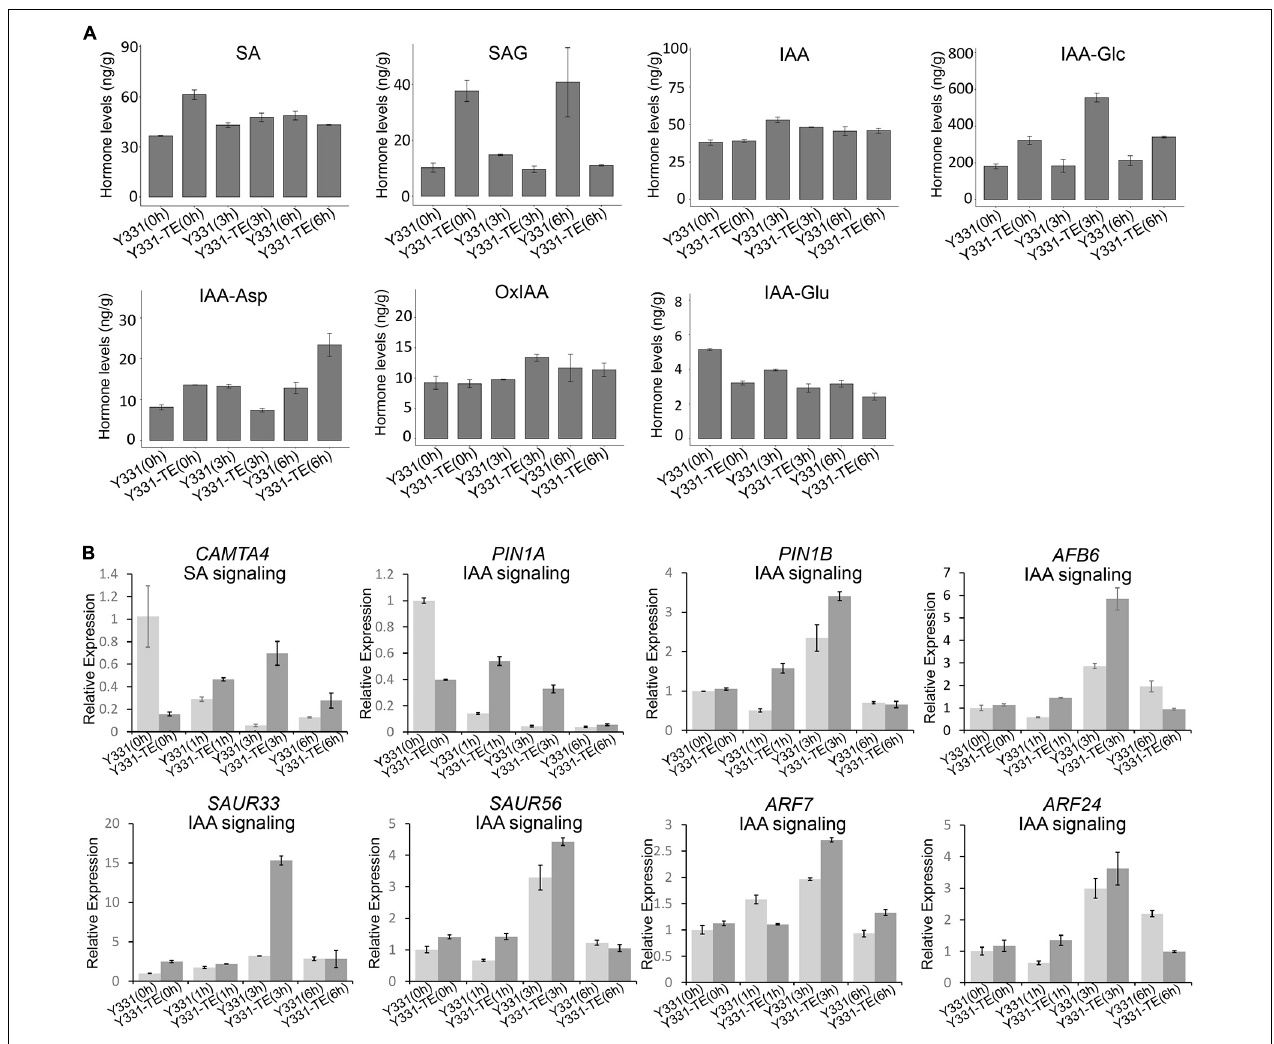
FIGURE 5 | Hormone level changes in Y331- (cid:49) TE and Y331 during infection of Fusarium graminearum. (A) Determination of endogenous maize hormone contents by LC-MS/MS during F. graminearum infection on Y331- (cid:49) TE or Y331 at different time points. SA, salicylic acid; SAG, salicylic acid 2-O- β -glucoside; IAA, indole-3-acetic acid; IAA-Asp, indole-3-acetyl- L -aspartic acid; IAA-Glc, 1-O-indol-3-ylacetylglucose; OxIAA, 2-oxindole-3-acetic acid; IAA-Glu, indole-3-acetyl glutamic acid. (B) Relative expression of hormone signaling pathway-related genes in F. graminearum -infected maize seedling root at different time points. The β -actin gene ZmActin was used as an internal control for normalization. For each gene, the relative enrichment value in Y331-infected seedling root cells at 0 hpi was assigned as 1. Error bars present the ± s.d. of three biological